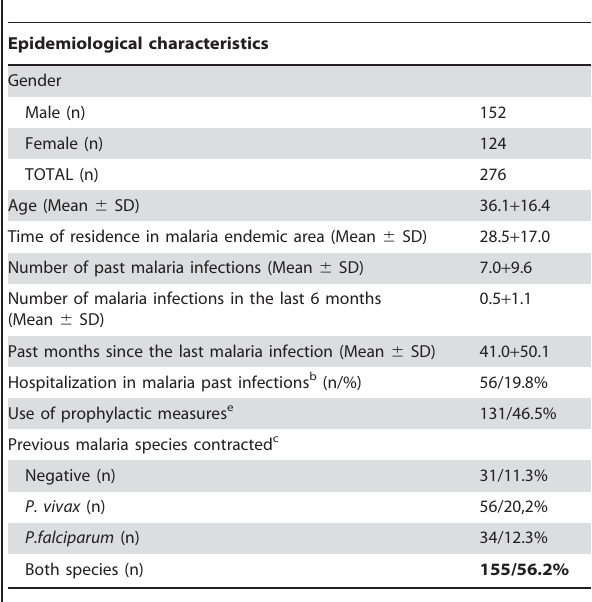
Table 1. Summary of the epidemiological characteristics of studied individuals enrolled in this